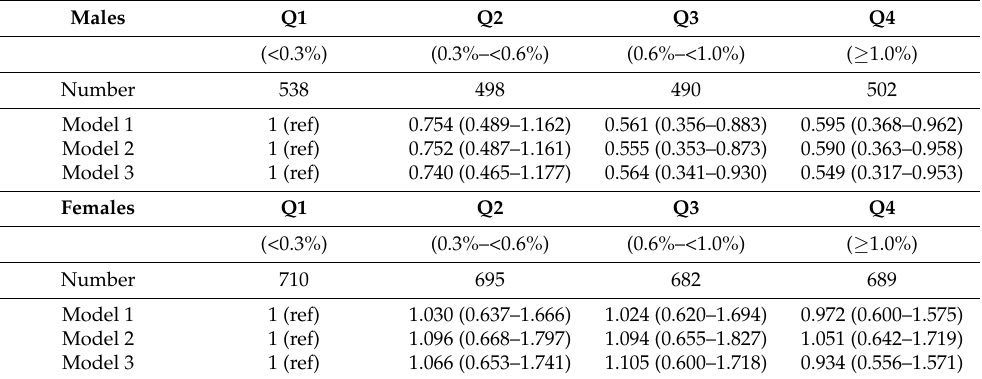
Table 4. Adjusted odds ratios (ORs) and 95% confidence intervals (CIs) of subclinical inflammation by quartiles of ω 3FA